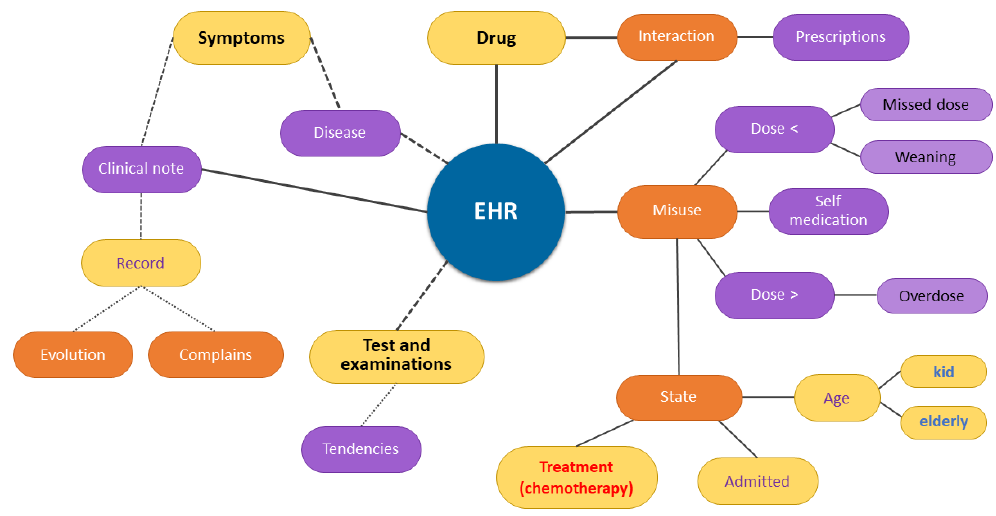
Figure 5. Mind Map—ADR from